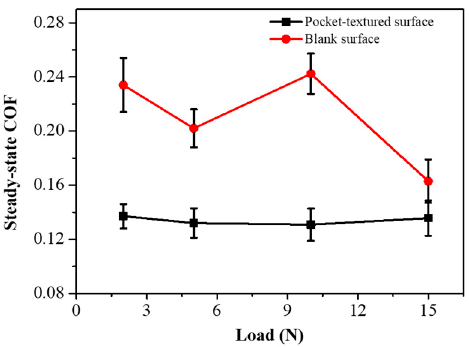
Figure 9. Steady-state coefficients of the pocket-textured surface and blank surface under different loads while the sliding frequency is kept at 0.5 Hz.